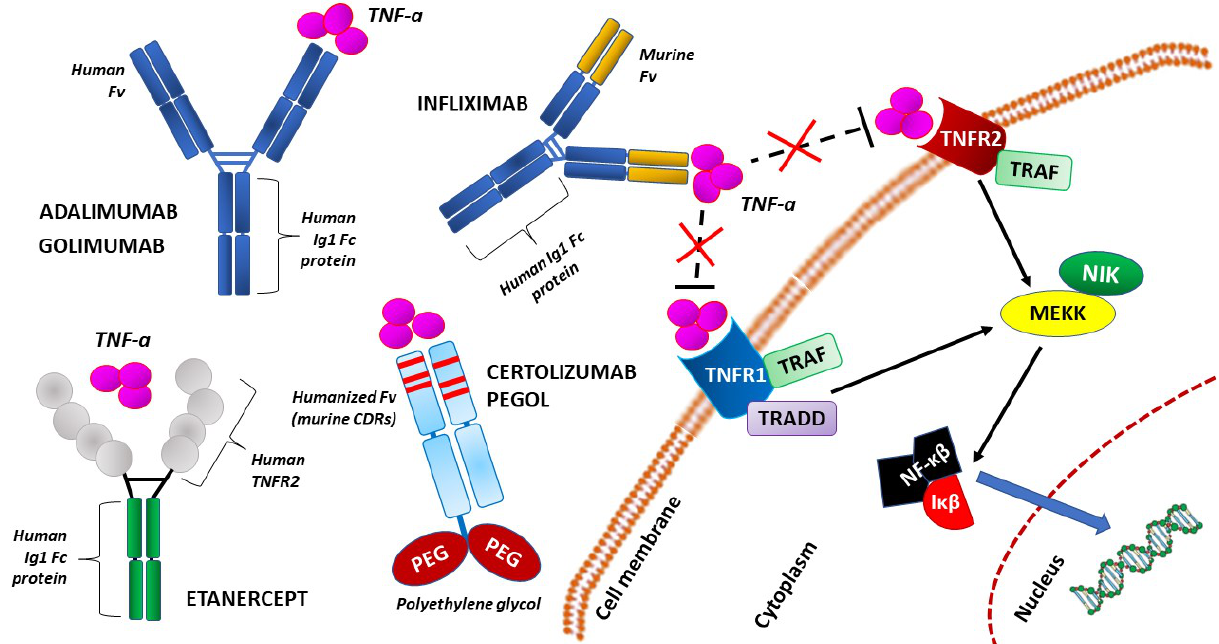
Figure 1. Simplified molecular structure of the representative compounds of tumor necrosis factor- alpha (TNF- α ) inhibitors: infliximab, adalimumab, golimumab, certolizumab pegol, and etanercept. Adalimumab and golimumab both contain similar human IgG1 Fc and Fv components. Infliximab contains the variable regions of a mouse anti-TNF-alpha monoclonal antibody alongside its constant human IgG1 Fc. Etanercept contains a constant human IgG1 Fc region, as well as a TNFR2 region. Certolizumab pegol contains a PEGylated humanized Fab region. CDR—complementarity-deter- mining region; Fab – antigen-binding fragment; Fc—fragment crystallizable; Fv—the smallest anti- body fragment that contains a complete antigen-binding site; I κβ — an enzyme complex IκB kinase; MEKK—mammalian mitogen-activated protein kinase kinase kinase; NF- κβ —nuclear factor kappa- light-chain-enhancer of activated B cells; NIK—NF- κB -inducing kinase; PEG—polyethylene glycol; TNF- α —tumor necrosis factor alpha; TNFR1—tumor necrosis factor receptor 1; TNFR2—tumor ne- crosis factor receptor 2; TRAF—tumor necrosis factor receptor-associated factor; TRADD—TNFR1- associated death domain protein.